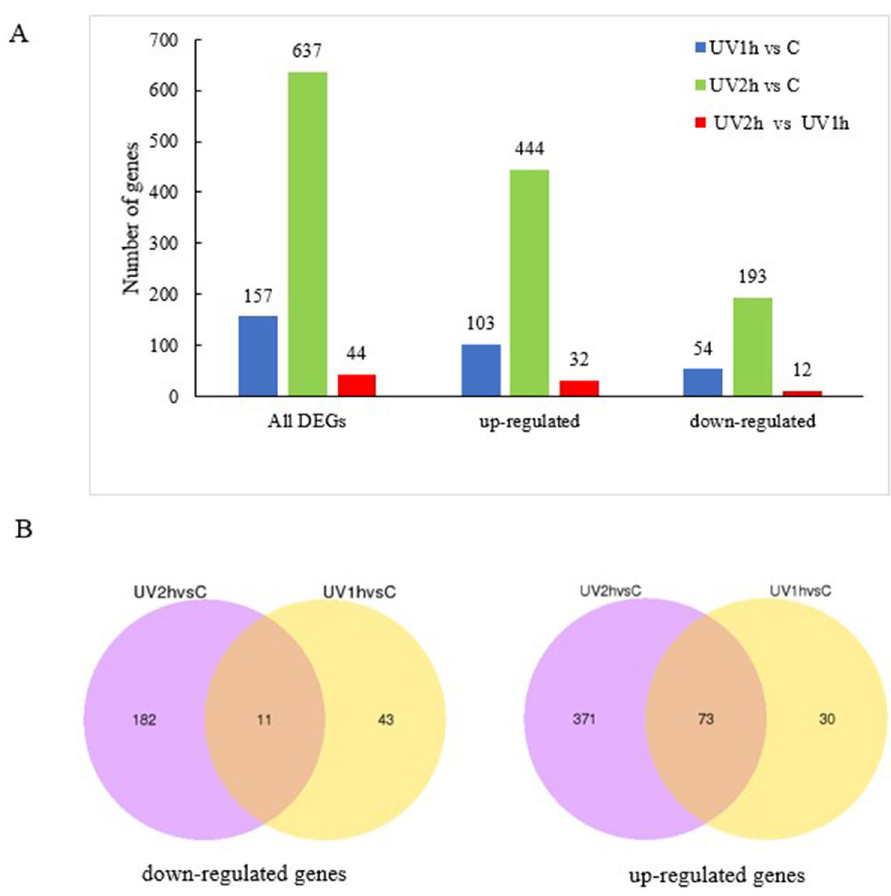
Figure 4. DEGs in Ostrinia furnacalis after UV-A exposure. (A) Histogram of the number of annotated unigenes in O. furnacalis after UV-A exposure. (B) Venn diagrams of common differential expression of upregulated (right) and downregulated genes (left) between UV-treated and control groups. DEGs differentially expressed genes, UV